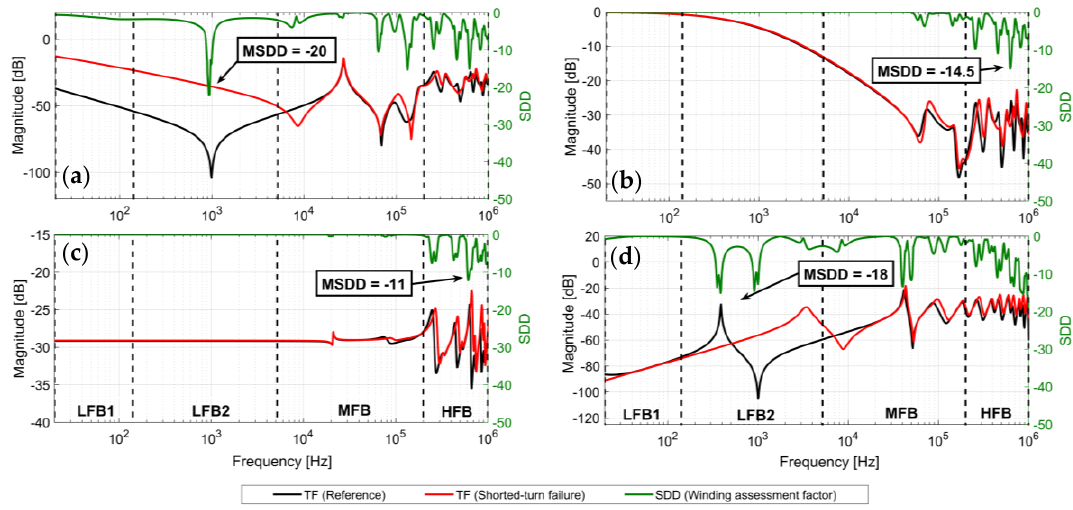
Figure 24. TFs of healthy and turn-to-turn SC failure in B-phase HV winding (vector group YNyn0) and SDD as a measure of deviation between TFs; ( a ) HV-OC, ( b ) HV-SC, ( c ) IIW, ( d ) CIW.